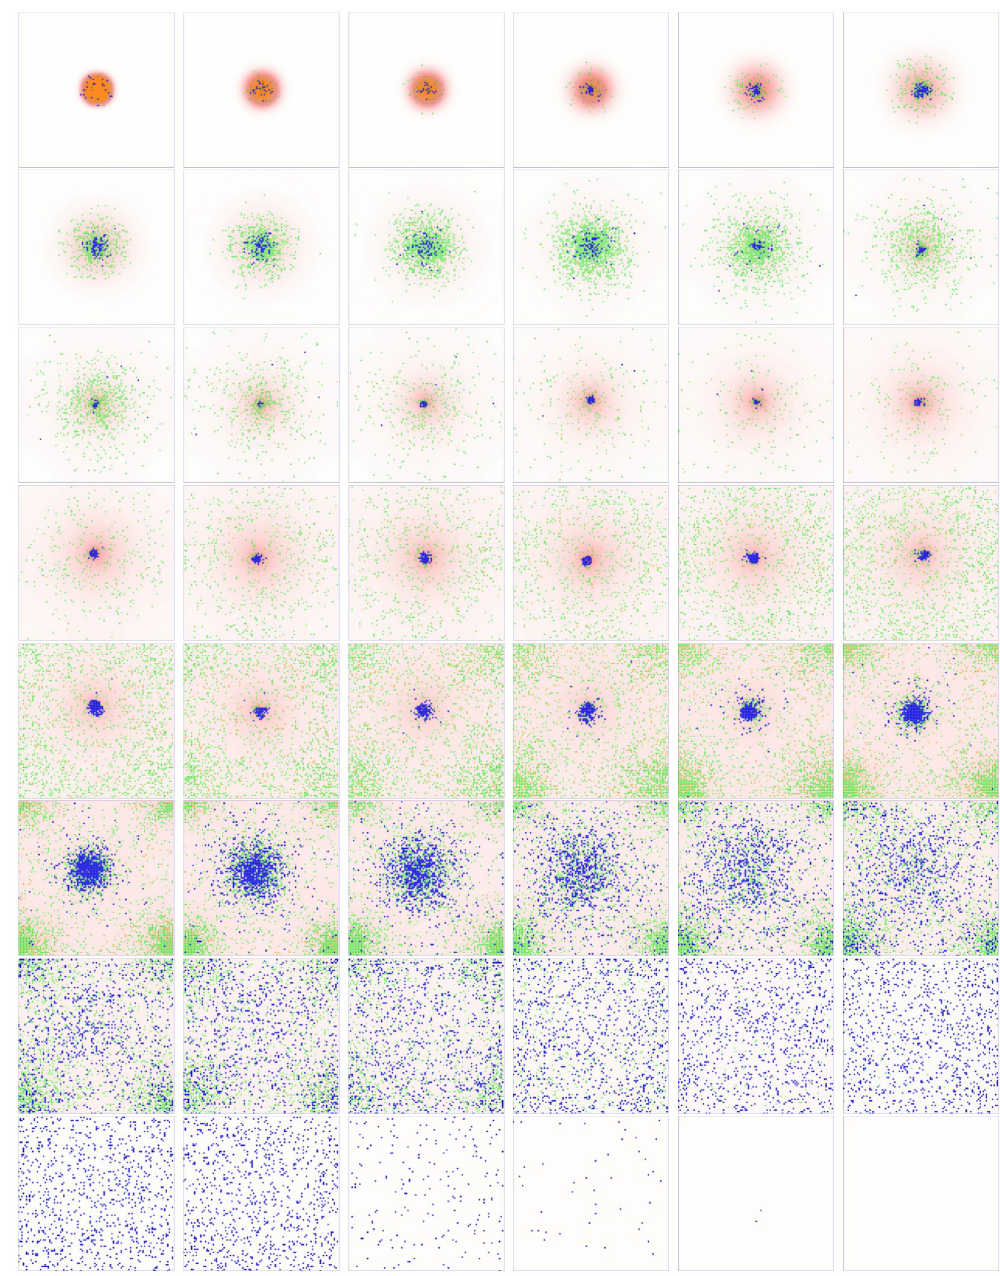
Fig 9. Snapshots of a typical healthy response, for healthy choices of chemotactic parameters ( k grad = 80, σ mem = 1), α mr = 0.25 and all other model parameters as given in Table 1. High levels of pro-inflammatory mediators are shown in dark reds in the background; active/apoptotic neutrophils are shown in green/orange respectively and macrophages are shown in blue. Corresponding time-courses showing global cell counts and mediator concentrations are shown in green in Fig 10.